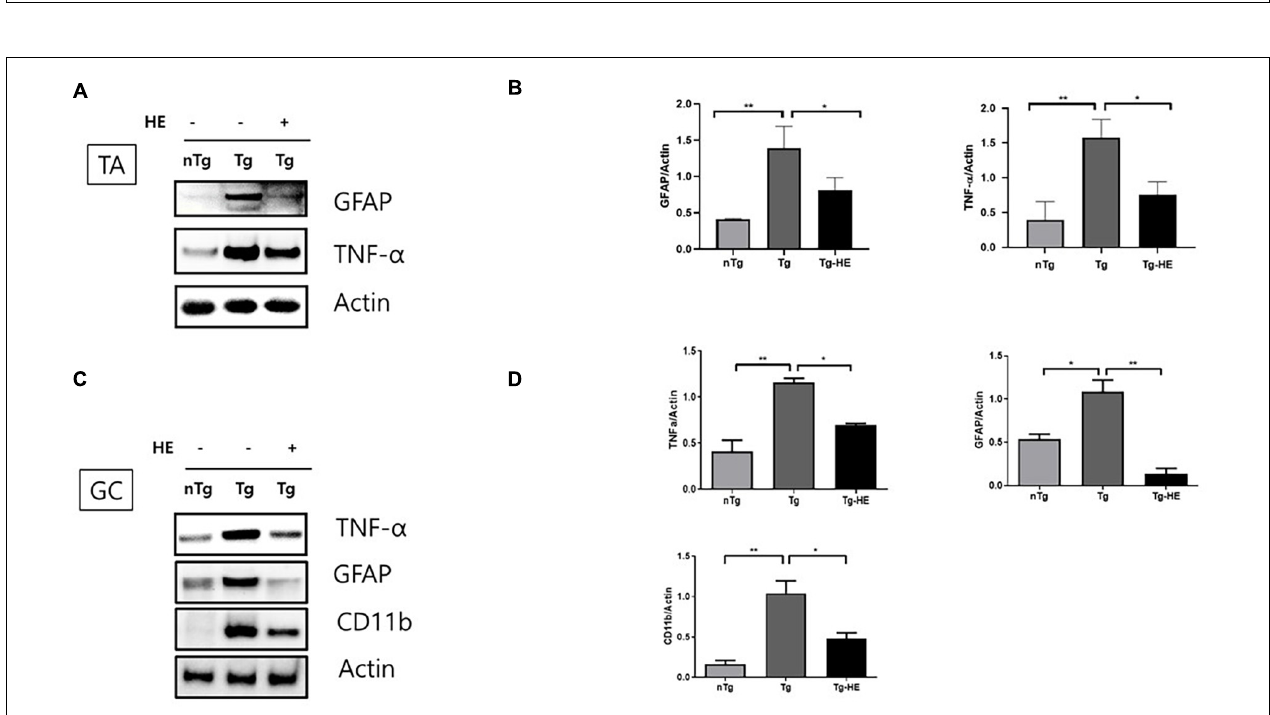
FIGURE 1 | Effect of herbal extract (HE) on the motor functions in hSOD1 G93A mice. (A) The body weight and tibialis anterior (TA) or gastrocnemius (GC) muscle weight of non-transgenic mice, hSOD1 G93A mice, and HE-treated hSOD1 G93A mice. (B) Comparison of outcome of rotarod and footprint tests between groups. Data are expressed as the mean ± SEM ( N = 8, * p < 0.05, ** p < 0.01, *** p < 0.001, and **** p < 0.0001). The statistical analyses were conducted using one-way ANOVA followed by Bonferroni’s multiple comparison tests. nTg, non-transgenic mice; Tg, hSOD1 G93A mice; Tg-HE, HE-treated hSOD1 G93A mice.